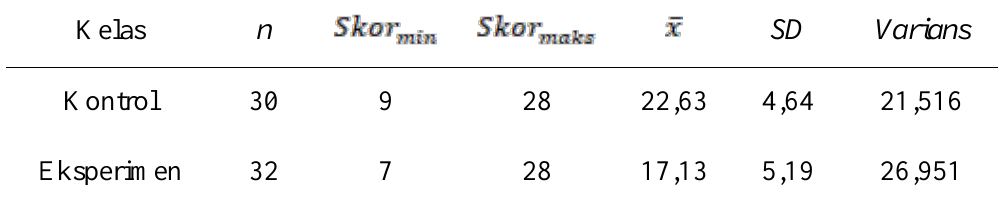
Tabel 2. Statistik Deskriptif Skor